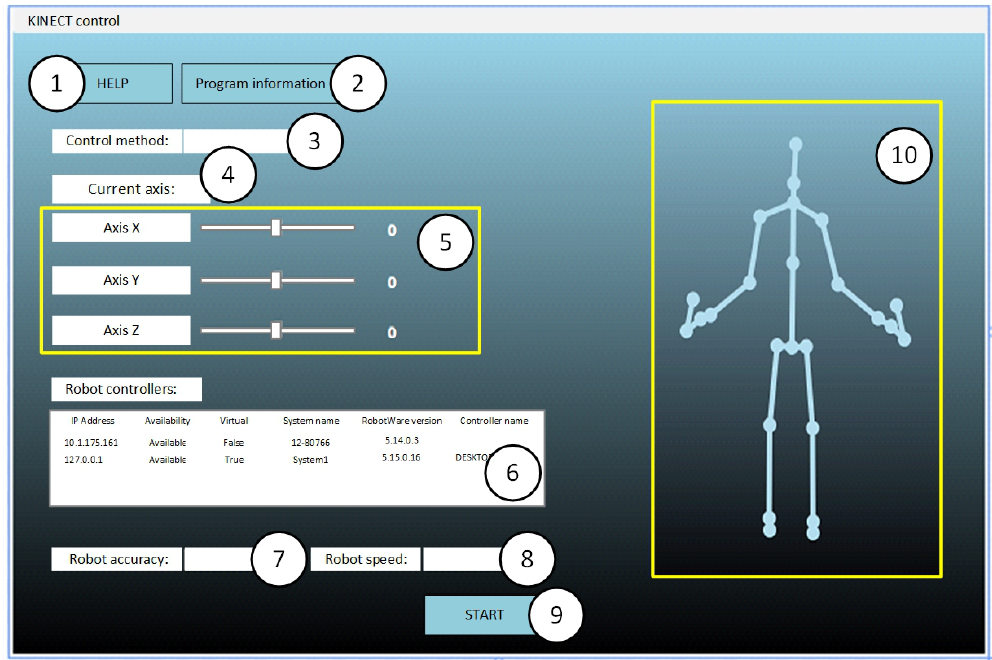
Figure 6. Graphical interface of the developed application: 1—help button, 2—program information of available robots, 7—robot accuracy window, 8—robot speed selection window, 9—start button, 10—operator’s “skeleton”